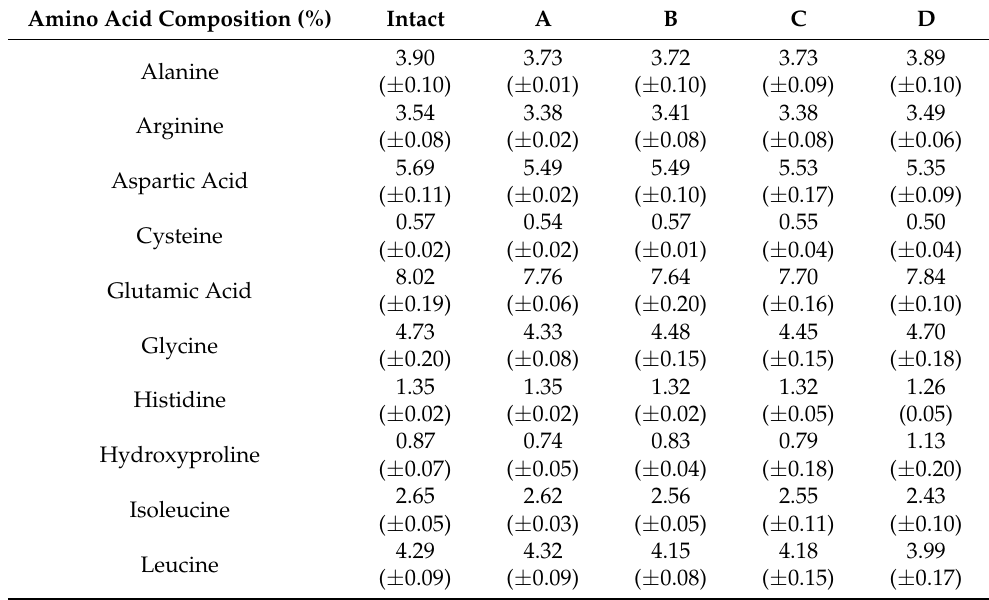
Table 2. Amino acid composition of the formulated